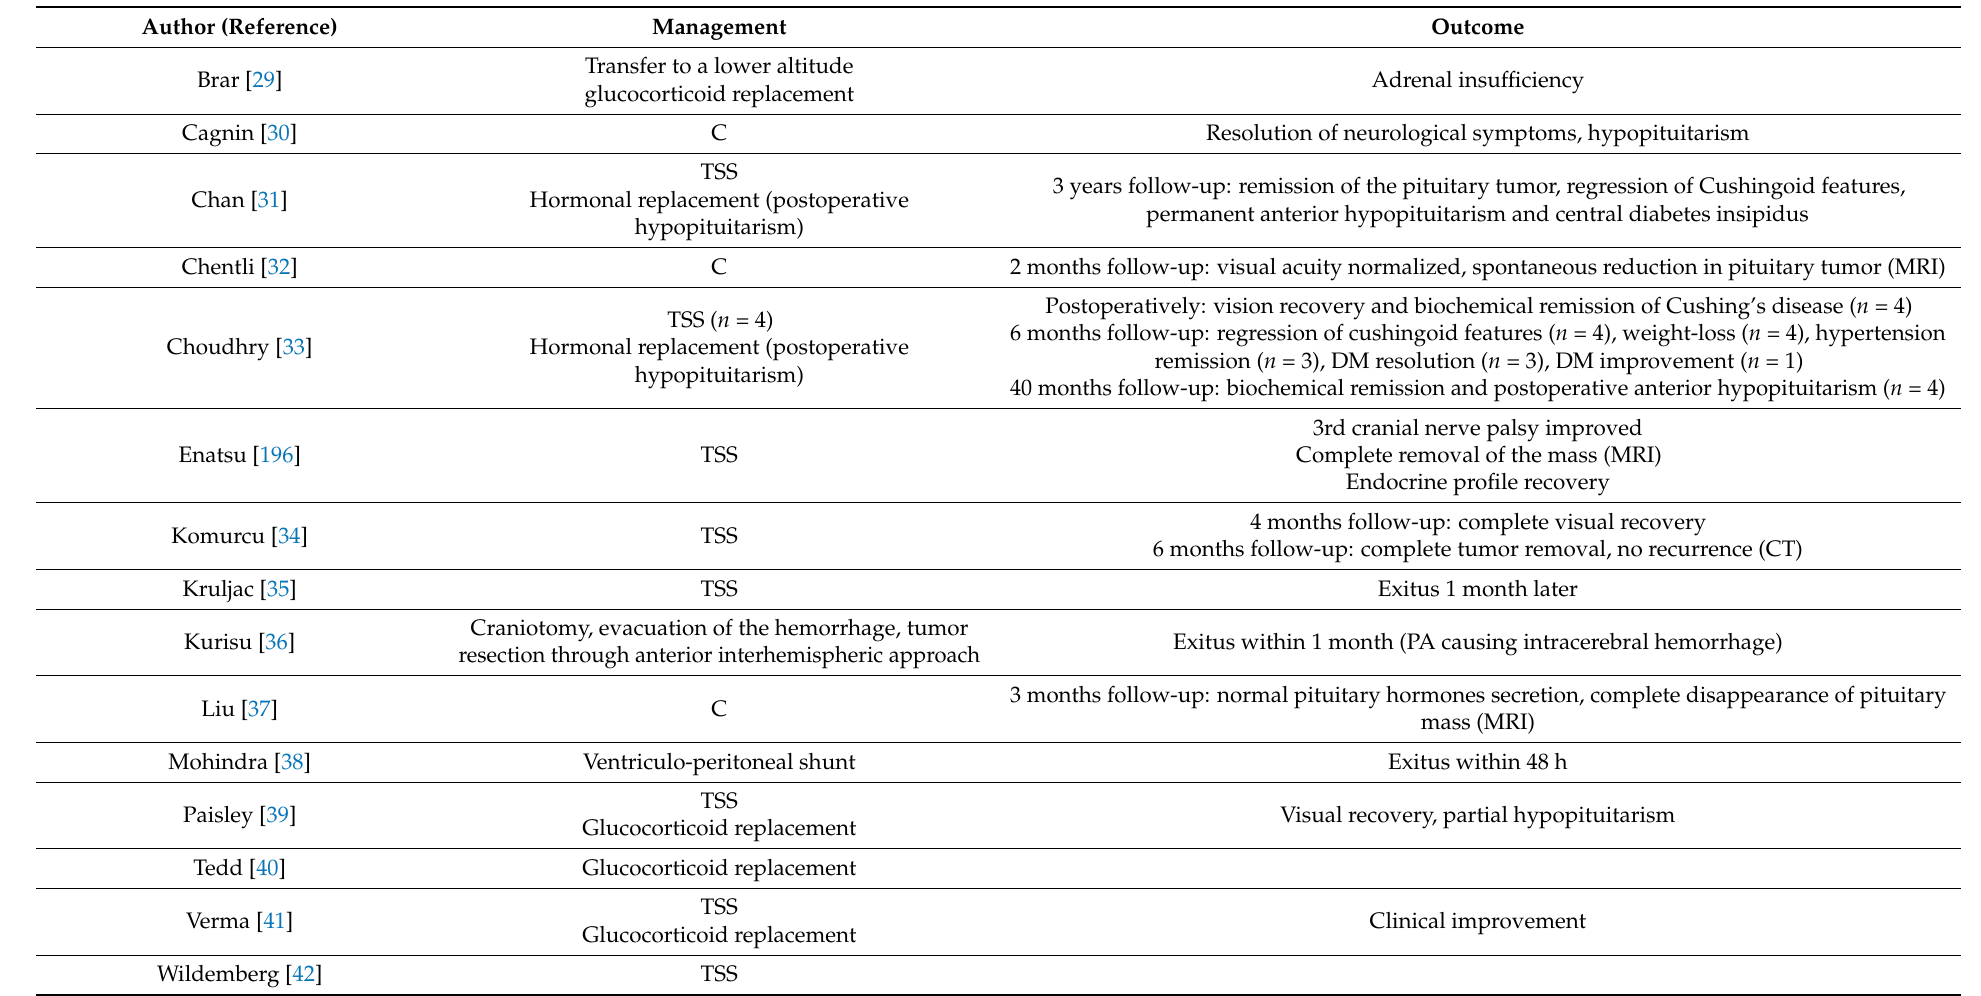
Table 2. Management and outcome in patients PitNET–PA